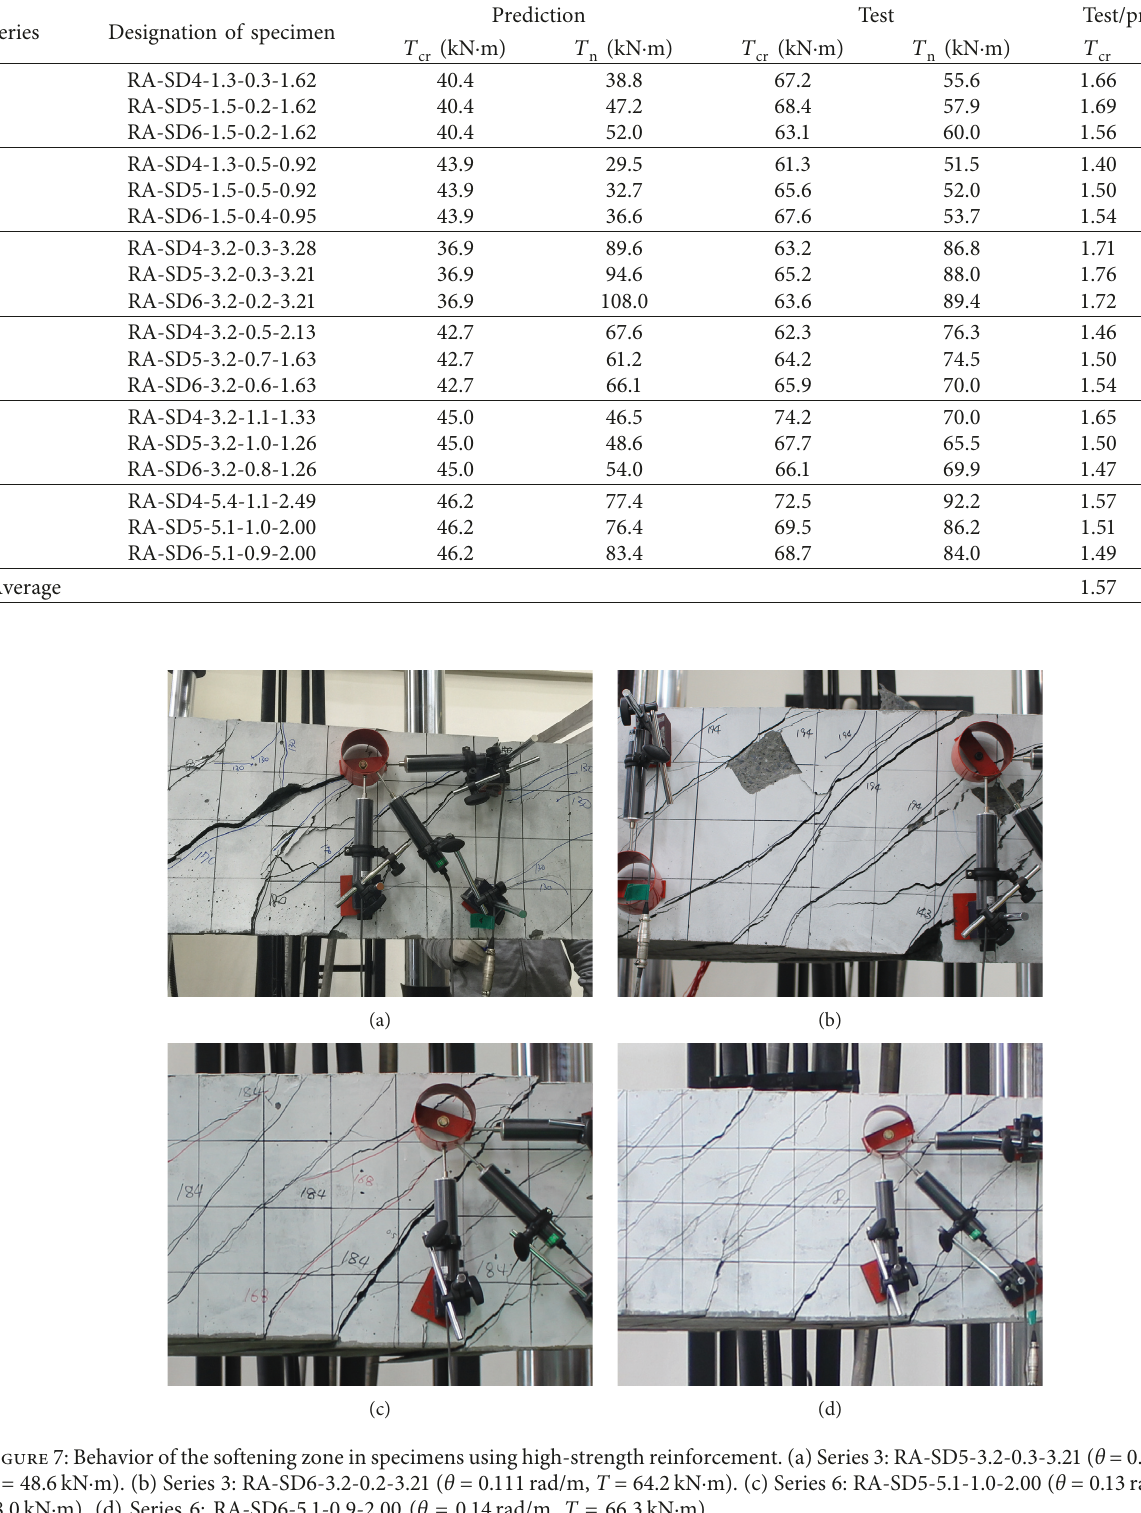
Table 5: Comparison of predicted and experimental torsional